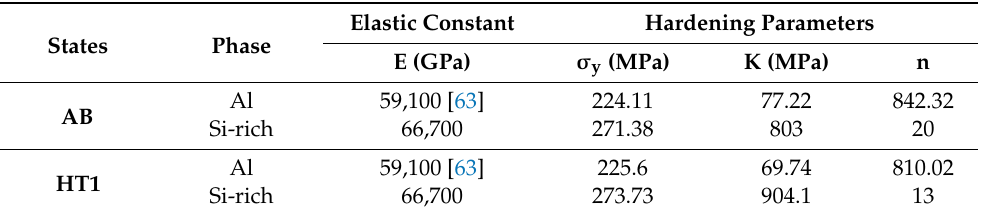
Table 3. Optimized CP parameters for Al determined by inverse analysis. See text for details.